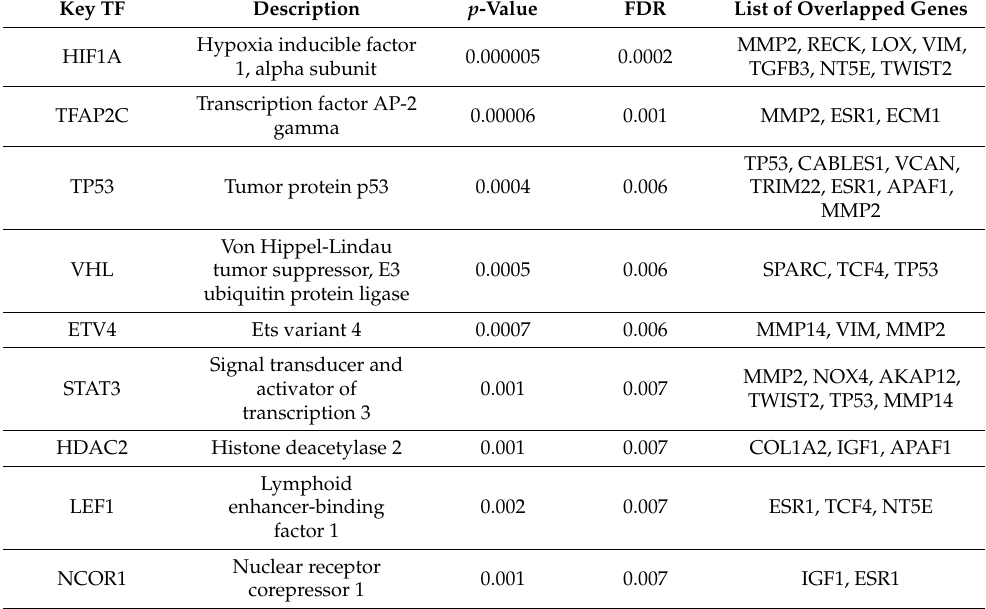
Table 2. Key transcription regulators (TF) targeting the hub genes in turquoise